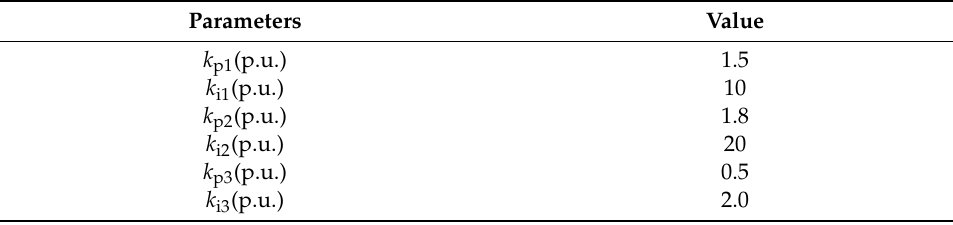
Table A2. Parameters of